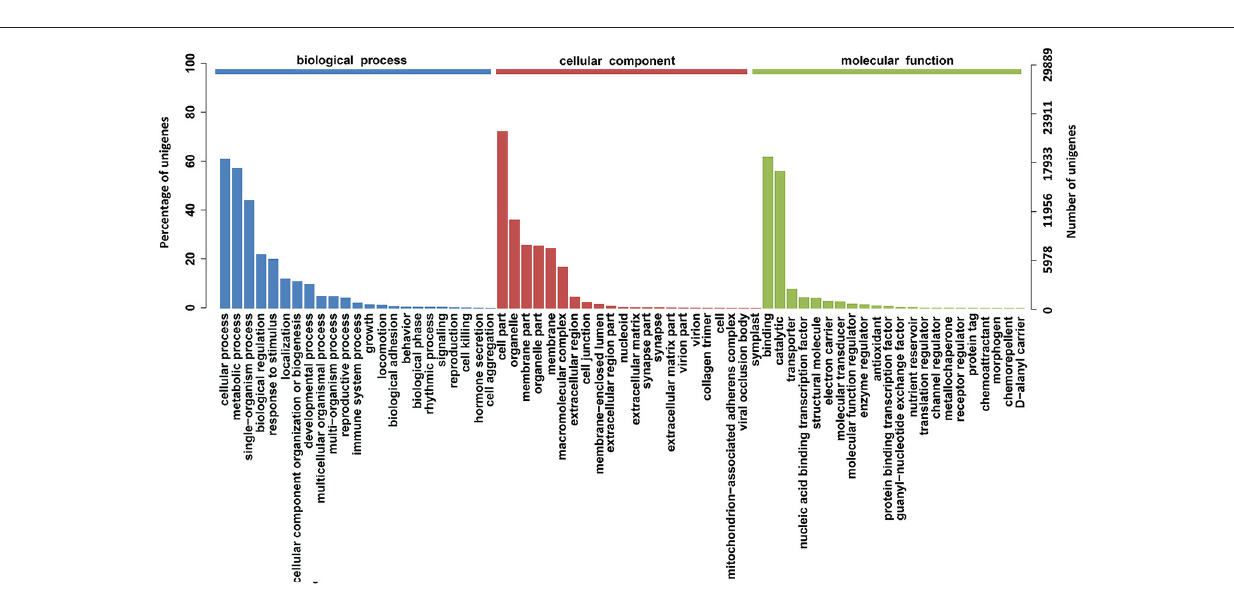
FIGURE 5 | GO function classification of the annotated unigenes in Alopecurus aequalis . The unigenes were allocated to three categories: biological process, cellular component, and molecular